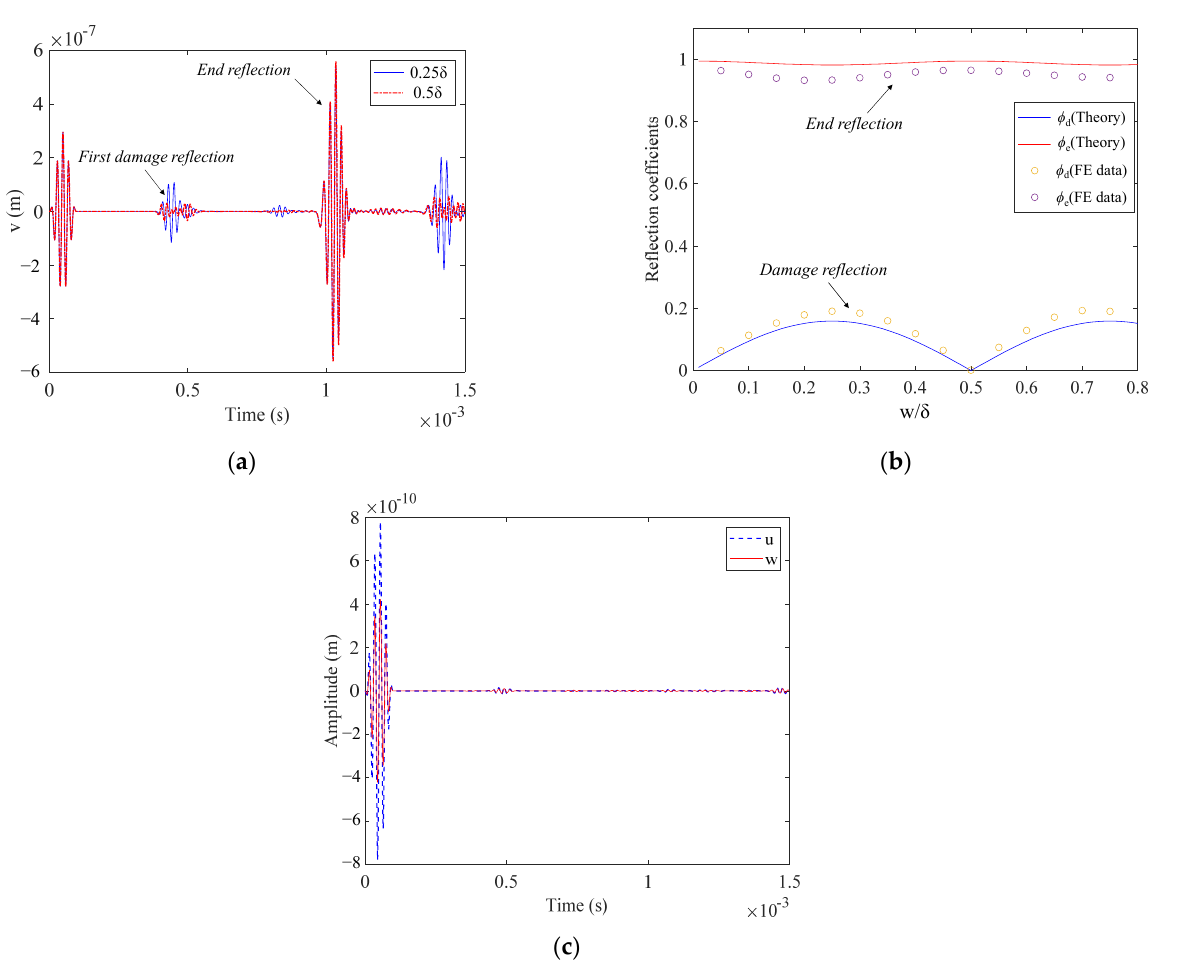
Figure A1. Defect model with complex cross-section.